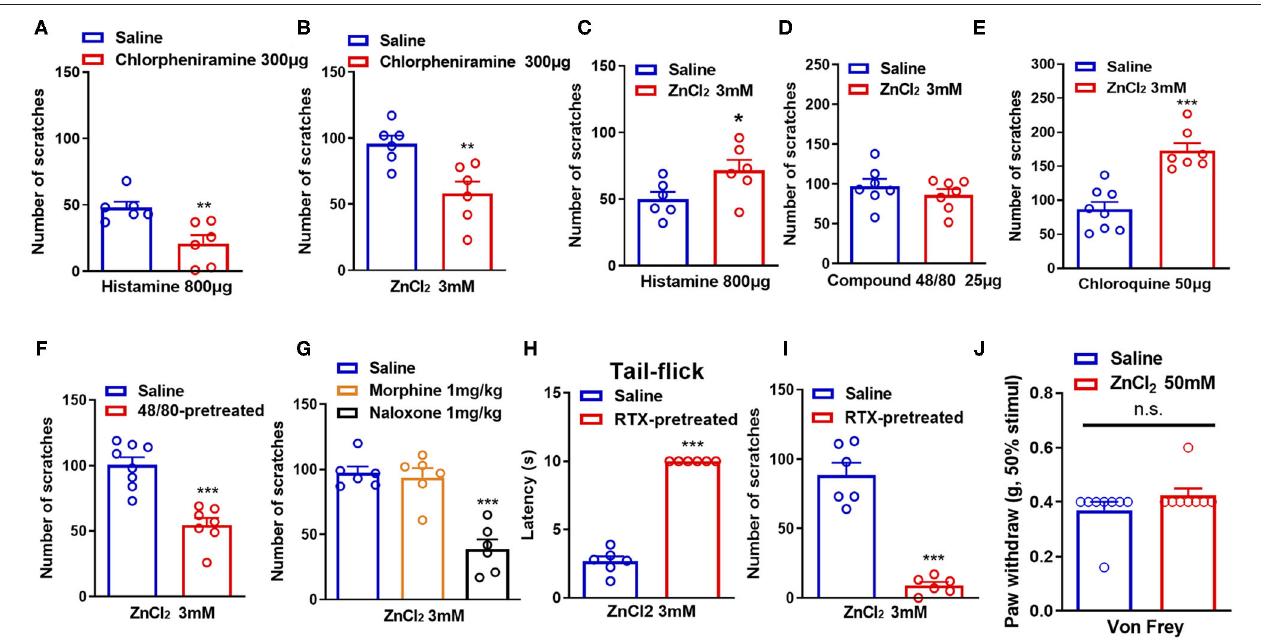
FIGURE 2 | Histamine, mast cells, opioid receptors, and capsaicin-sensitive C-fibers participate in ZnCl 2 -induced itch in mice. (A) The effects of coadministration of a histamine H1 receptor antagonist chloropheniramine (300 µ g) on histamine (800 µ g)-induced itch in mice. (B) The effects of coadministration of chloropheniramine (300 µ g) on ZnCl 2 (3mM)-induced itch in mice. (C–E) The effects of coadministration of ZnCl 2 (3mM) on histamine [800 µ g; (C) ]-, compound 48/80 [25 µ g; (D) ]-, chloroquine [50 µ g; (E) ]-induced itch in mice. ( F ) Pretreatment of compound 48/80 (200 µ g) on ZnCl 2 (3mM)-induced itch in mice. (G) The effects of systemic administration of morphine (1 mg/kg) and naloxone (1 mg/kg) on ZnCl 2 (3mM)-induced itch in mice. (H) The effects of systemic administration of resiniferatoxin (RTX) on the latency time of tail flick response to hot water (52 ◦ C). (I) The effects of C-fiber depletion on ZnCl 2 (3mM)-induced itch in mice. (J) After intraplantar injection of ZnCl 2 (50mM, 20 µ l) in the hind paw, the Von Frey test was used to detect the mechanical pain threshold in mice (* P < 0.05, ** P < 0.01, *** P < 0.001 vs. Saline, unpaired Student’s t -test; n = 6–9 per group). All data are expressed by means ± SEM. n.s., not significant.